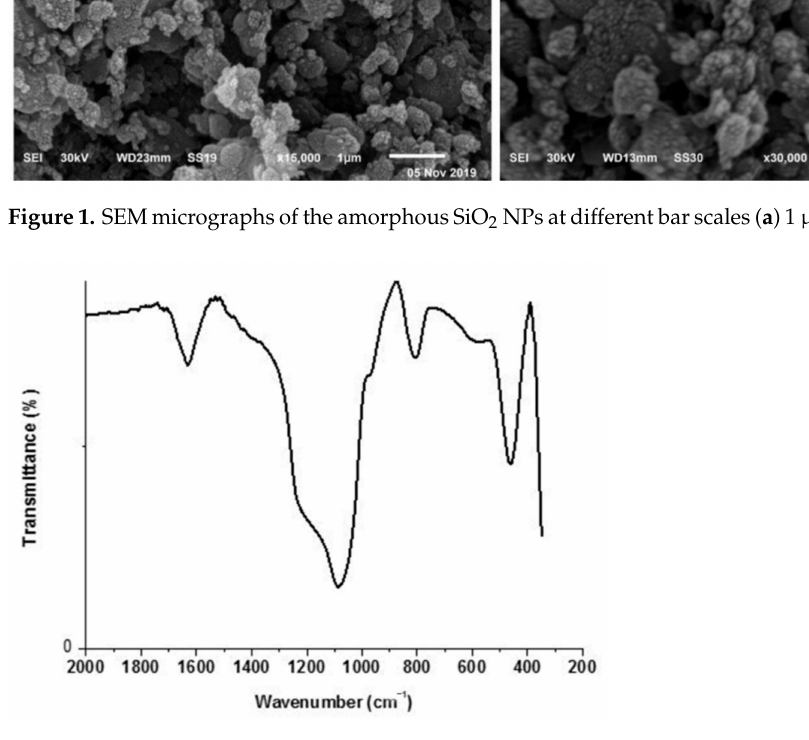
Figure 2. FTIR spectra of the amorphous silica prepared with